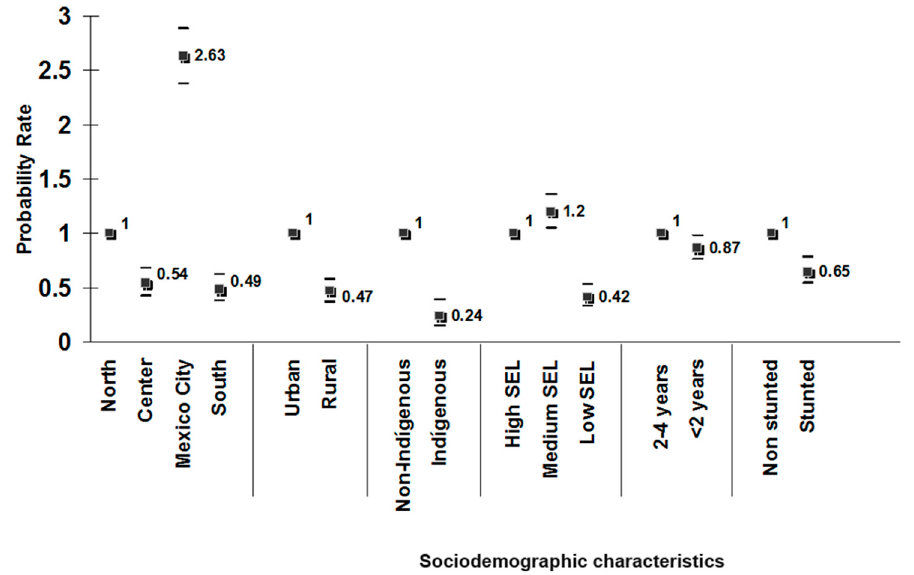
Figure 3. Probability rate ( ± 95% C.I.) of participation in food programs in households with children <5 years of age in 1988. Adapted from a published source [9], N = 7246 children <5 years, National Nutrition Survey 1988.